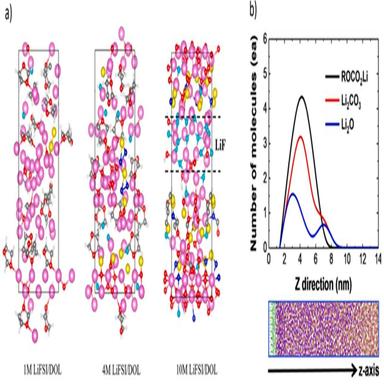
.1. ReaxFF-based molecular dynamics simulations of SEI formation. In (a) it is shown the concentration effect of lithium bis(fluorosulfonyl)-imide (LiFSI, F2LiNO4S2) in dioxalane (DOL) at concentrations of 1 M, 4 M, and 10 M after 1 ns. Purple, red, grey, cyan, yellow, blue and white balls stand for Li, O, C, F, S, N and H atoms, respectively. At 1 M and 4 M concentrations the SEI is heterogeneous, with the presence of clusters and voids; in contrast, at 10 M, the simulations reveal the formation of a rathe